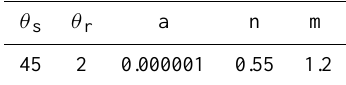
Fig. 10. Numerical modelling of the protection area around the Figure 10. Numerical modelling of the protection area around the structure structure. Table 1. Case study, retention curve